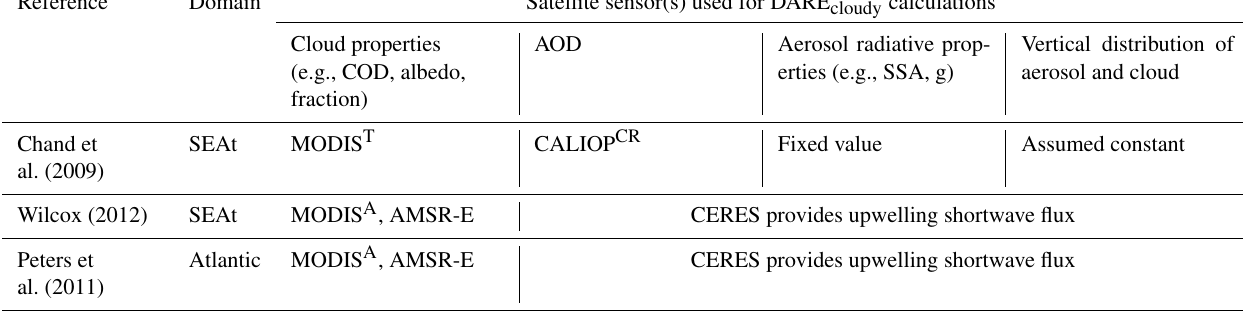
Table 1. TOA SW DARE cloudy calculations that use satellite observations in the literature and specific assumptions in the calculations. See also the theoretical study by Chang and Christopher et al. (2017) (i.e., they impose fixed COD, Re, AOD, aerosol radiative properties, and aerosol/cloud vertical distribution) and the study by Costantino and Bréon et al. (2013) (their method uses MODIS-derived cloud microphysics that are not corrected for overlying aerosols). When not specified, the study uses the standard CALIOP data product; otherwise, it uses the DR (depolarization ratio) or CR (color ratio) technique on CALIOP measurements. MODIS A and MODIS T denote the AQUA and TERRA platform respectively. SEAt: southeast Atlantic. LUT: look-up table. See acronyms for satellite sensors MODIS, CALIOP, CloudSat, POLDER, CERES and